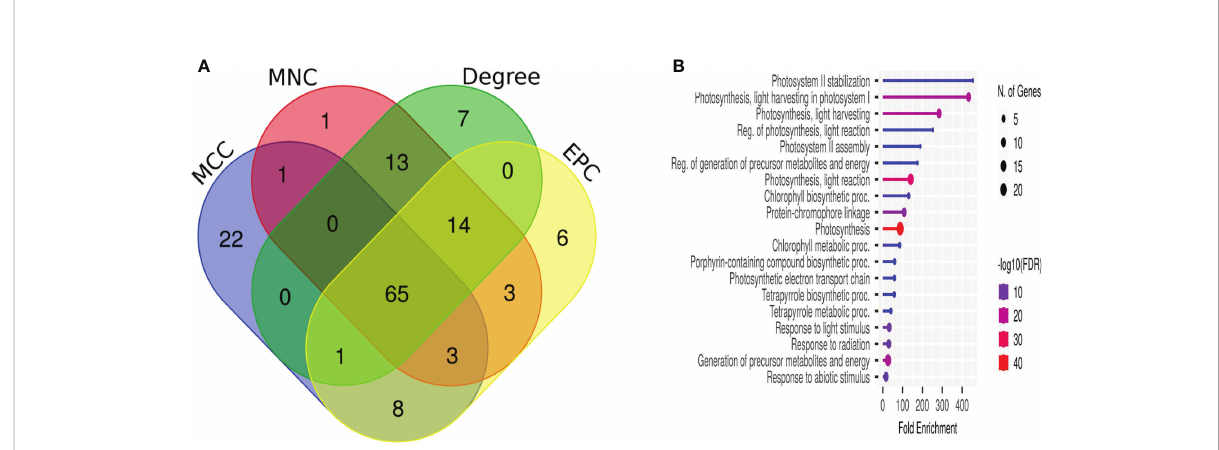
FIGURE 4 Protein – protein interaction network assembly of core genes. (A) Venn diagram of the top 100 essential genes based on the CytoHubba four scoring method. (B) The biological process enrichment of core genes of cluster 1.